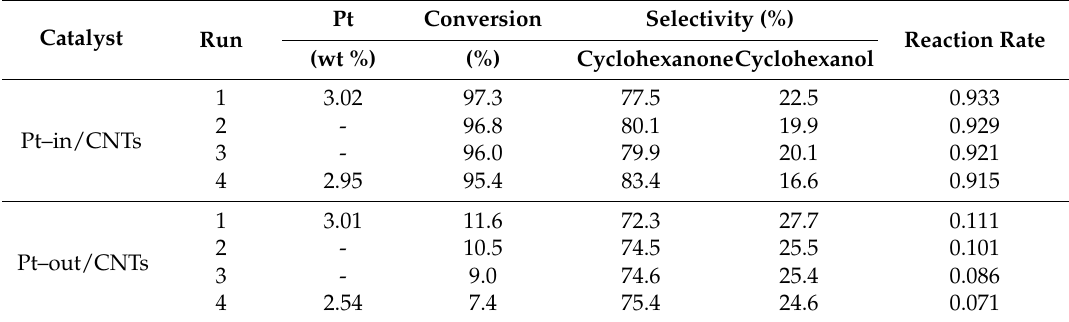
Table 3. Reusability of catalysts with different loading methods in the hydrogenation of phenol 1 .